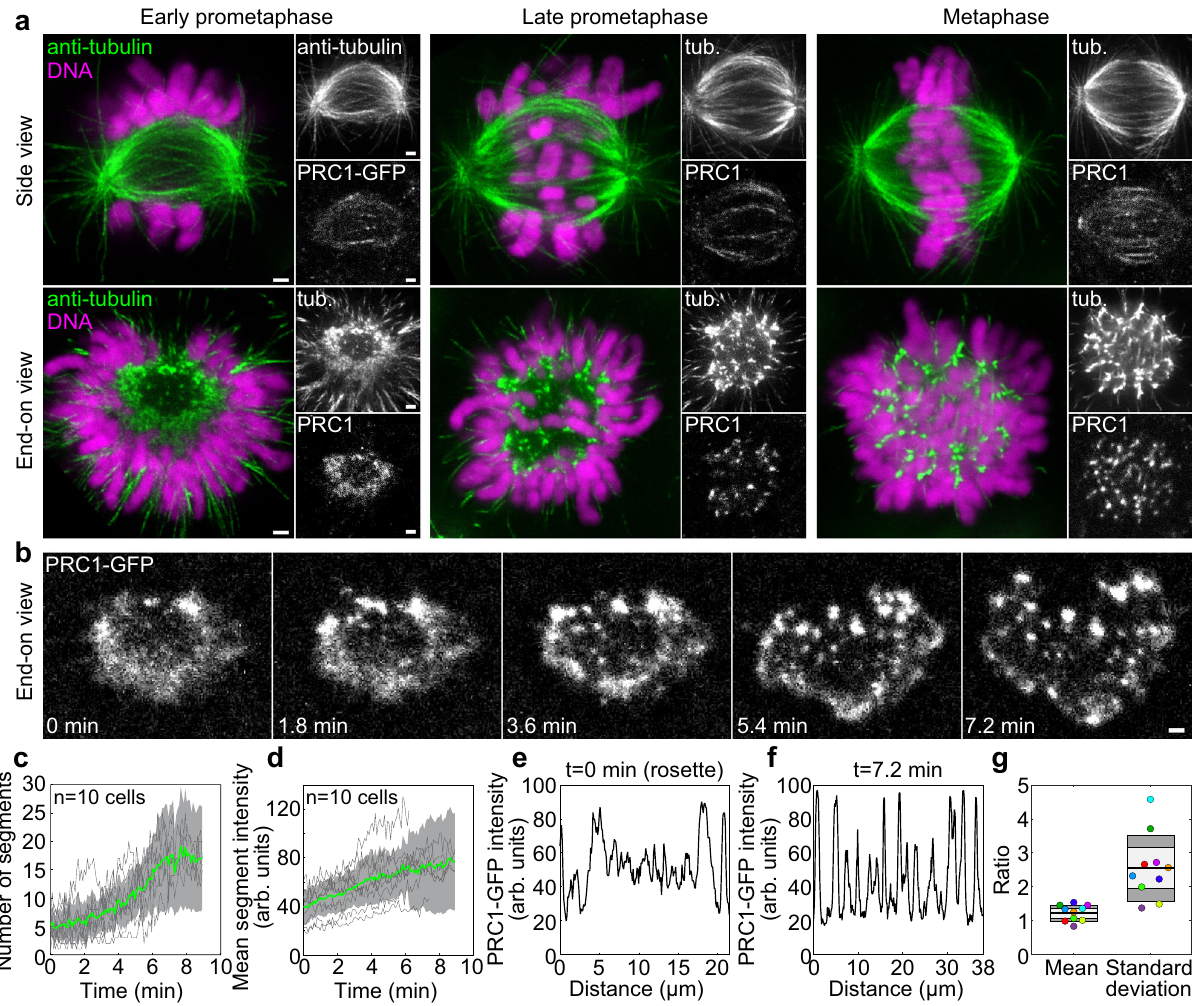
Fig. 1|PRC1-crosslinkedmicrotubulesundergoatransitionfromaloosearray tobundlesduringspindleassembly.a Spindlesimmunostainedfor α -tubulinand imaged at STED resolution in a HeLa-Kyoto BAC cell line stably expressing PRC1- GFP with DNA stained by DAPI (both imaged at a confocal resolution), in early prometaphase, late prometaphase, and metaphase. Spindles lying parallel ( fi rst row) or perpendicular (second row) to the imaging plane are shown. b Time-lapse images (single plane) of a cross-section of a vertically oriented prometaphase spindle in a HeLa-Kyoto BAC cell stably expressing PRC1-GFP, starting with the prometaphase rosette. c Number of PRC1 segments in the midplane over time for cells as in ( b ), obtained using Squassh segmentation. Gray lines represent